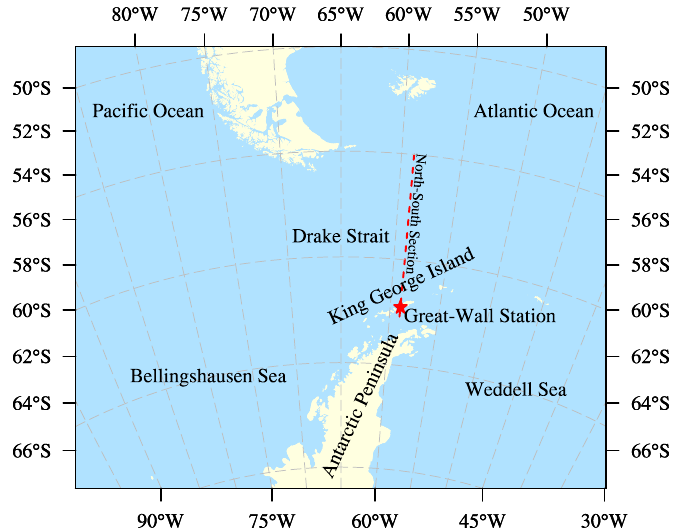
Figure 1. Map showing the location of the Great Wall Station (red star) on King George Island in Antarctica. The red dotted line indicates the location of the section in Figure 7.